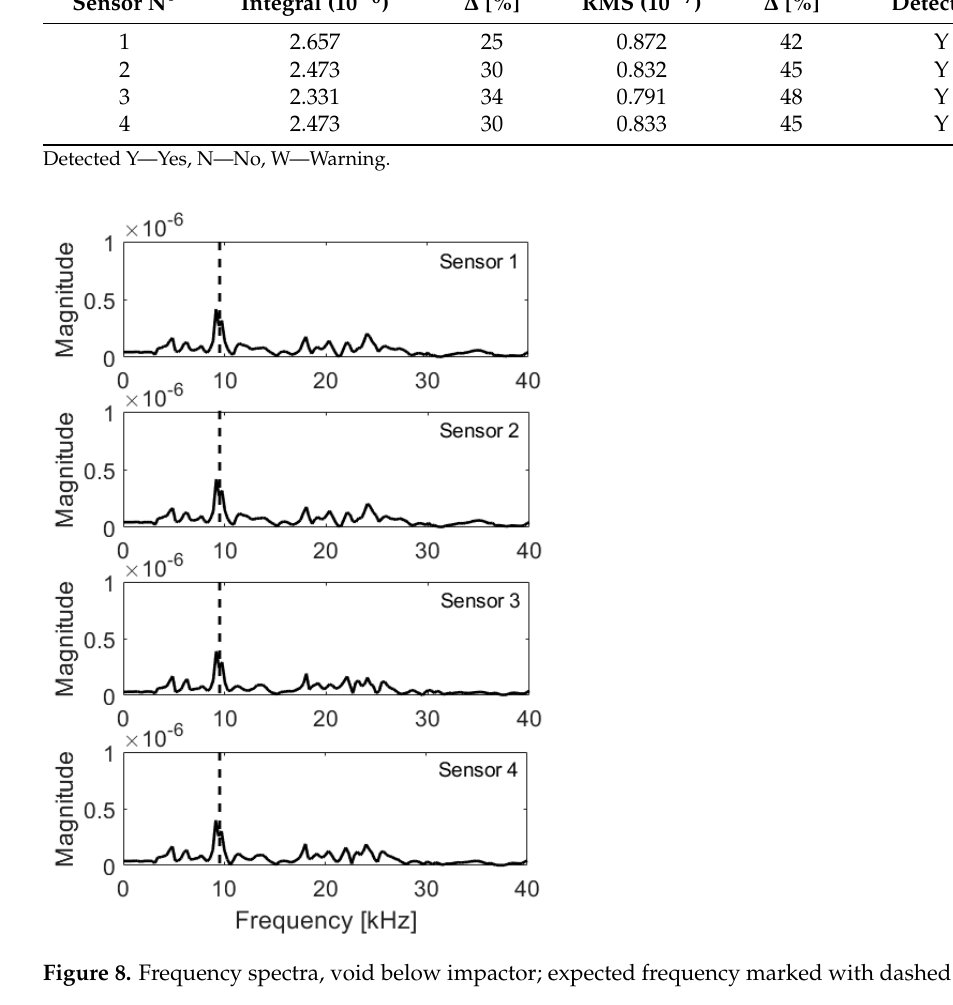
Figure 8. Frequency spectra, void below impactor; expected frequency marked with dashed line.